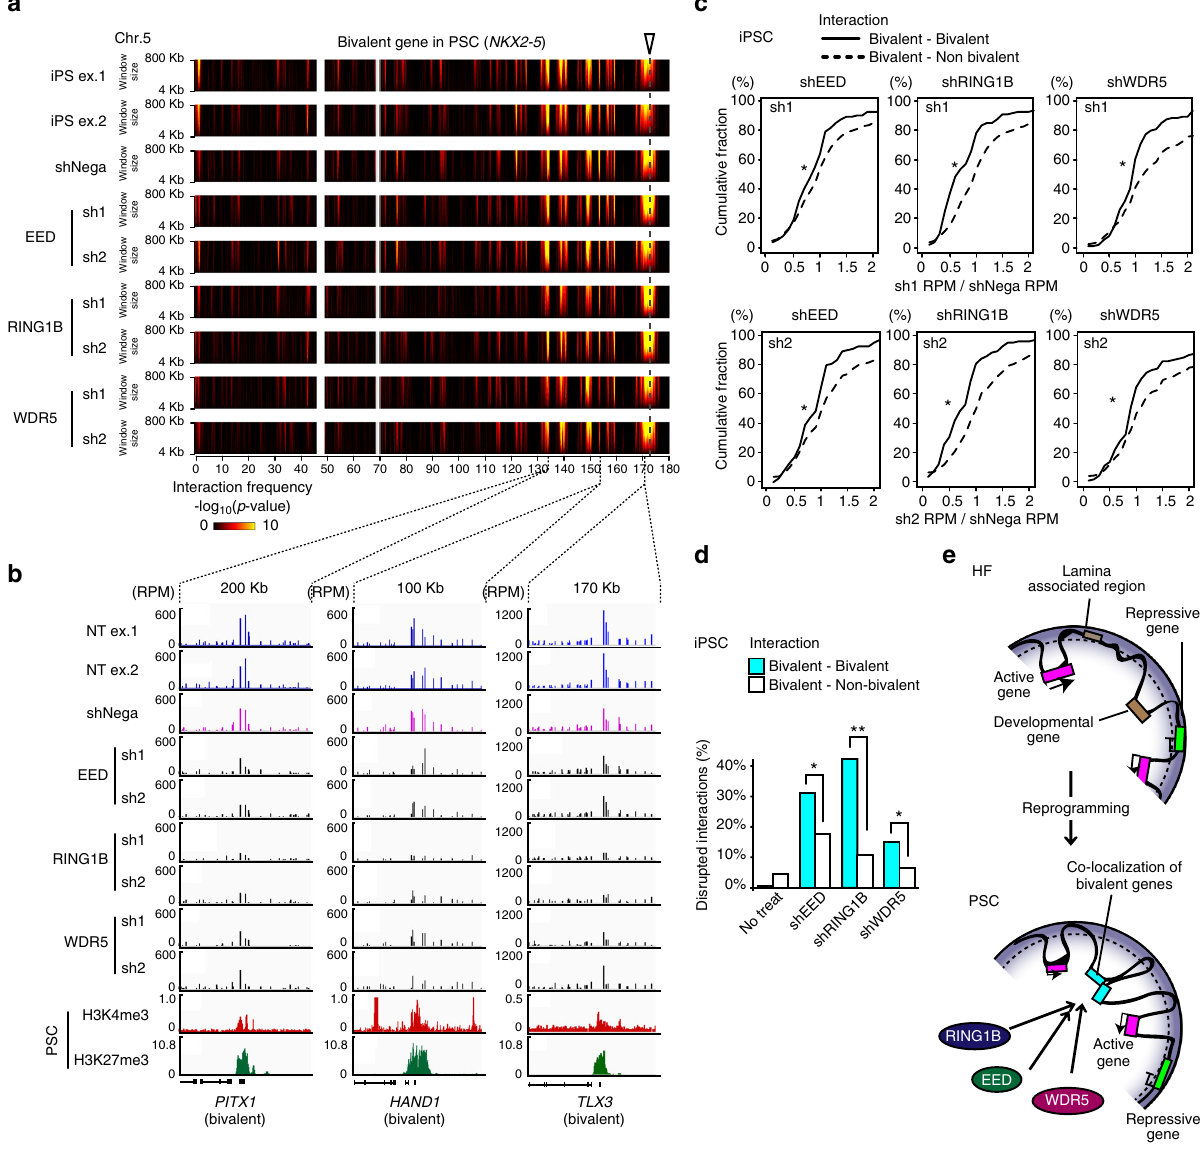
Fig. 6 EED, WDR4, and RING1B are important for the colocalization of bivalent gene loci. a Interaction pro fi les determined by ms4C-seq for the NKX2-5 gene locus in EED, WDR5, and RING1B KD iPSCs. Domainograms indicate cis -chromatin interaction frequencies at the NKX2-5 gene locus on an Mb scale in shRNA-treated iPSCs. b The disruption of chromatin interactions between bivalent gene loci by shRNA treatment. Bar plots indicate interaction signals (RPM) at interaction target gene loci of the NKX2-5 gene bait locus. ChIP-seq signals (RPM) for H3K4me3 and H3K27me3 histone modi fi cations in PSCs (ESCs) are shown under the ms4C-seq interaction signals. Reduced interaction signals of the bait NKX2-5 gene locus are detected in bivalent gene loci ( PITX1 , HAND1 , and TLX3 ) after shRNA treatment against EED, WDR5, or RING1B in PSCs (iPSCs). c Cumulative distribution of reduction rates for interaction signals (RPM values in TSS ± 25 kb) in bivalent – bivalent (solid line) and bivalent – nonbivalent (dashed line) interactions by two independent knockdown (two different shRNAs) experiments for EED, RING1B, or WDR5 in PSCs (iPSCs). * p < 0.03 was assessed for bivalent – bivalent interactions vs. bivalent – nonbivalent interactions by two-sided Mann – Whitney U -test. d Disruption of bivalent gene colocalizations by the KD for EED, WDR5, or RING1B. Bar graphs show the percentages of colocalized bivalent genes (light blue) and nonbivalent genes (white) with interaction signals (RPM values in TSS ± 25 kb) that were reduced to at least 30% following both sh1 and sh2 treatments for EED, WDR5, and RING1B compared to shNegative treatment (Fisher ’ s exact test, * p < 0.01, ** p < 1 × 10 − 6 ). e A model for the changes in chromatin interactions and subnuclear localization around bivalent gene loci during somatic cell reprogramming. See also Supplementary Fig.